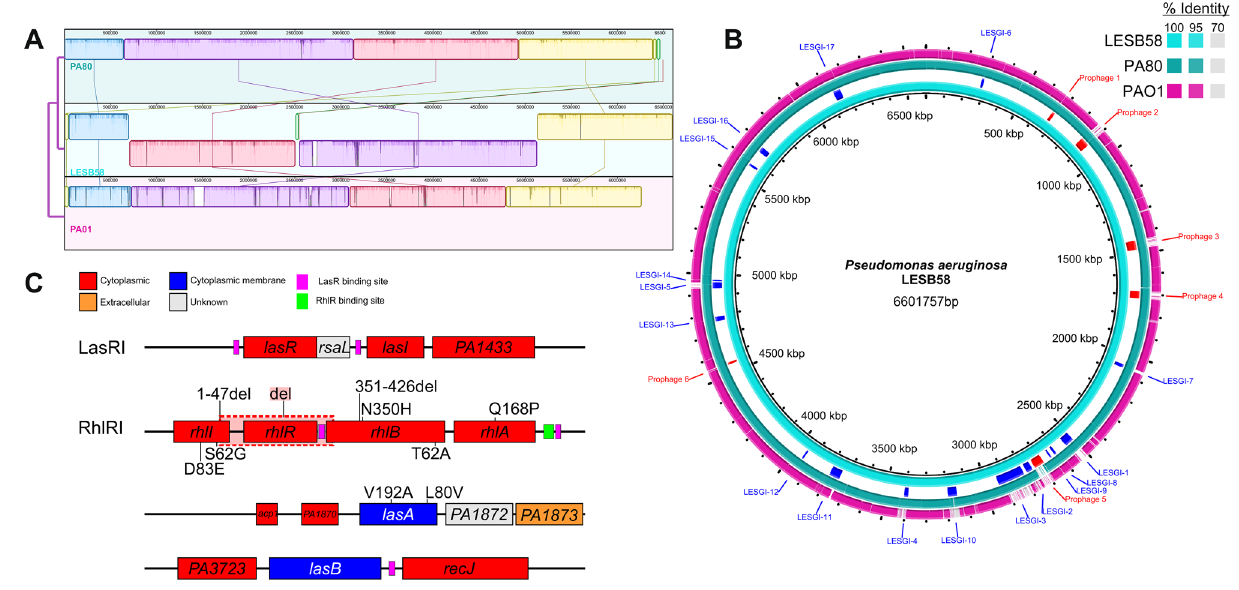
Figure 1. Comparative genomics of PA80. ( A ) Whole genome alignment of PA80, PAO1 and LESB58. PA80 shares 99.53% sequence identity to LESB58. ( B ) Whole genome comparison of PA80 with LESB58 and PAO1. LESB58 genomic islands are highlighted in blue and prophage region in red. Coordinates were mapped to LESB58 genome from Jani et al., 2016 88 . PA80 contains only one unique region relative to LESB58. PAO1 lack several of the GI’s and prophages identified in LESB58. ( C ) Genomic context of the main non-synonymous mutations in PA80. Shaded red indicates complete deletion of the rhlR